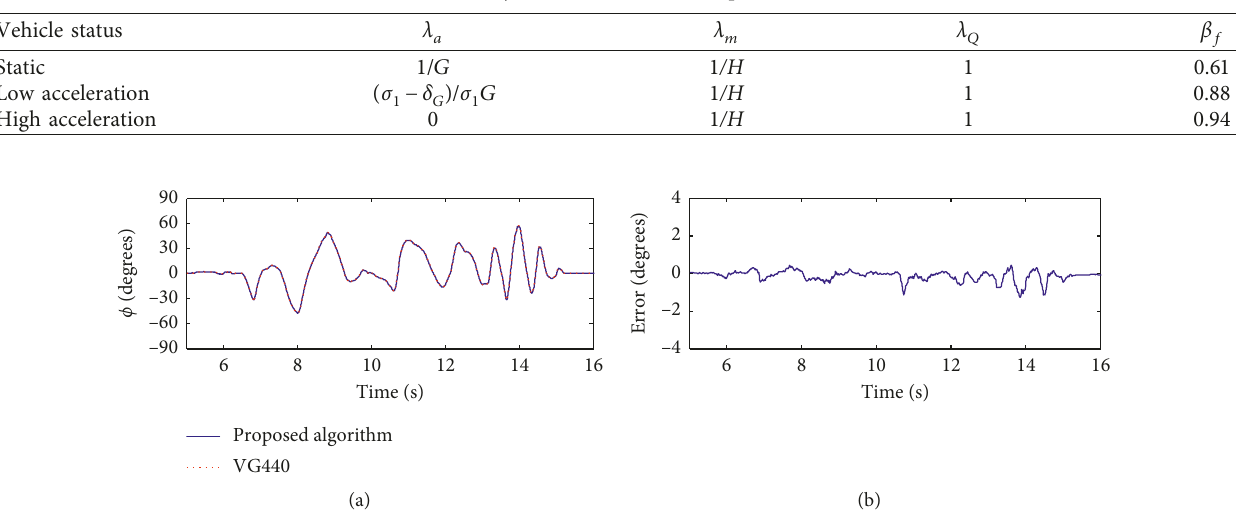
Table 2: Adjustment scheme of the parameters.